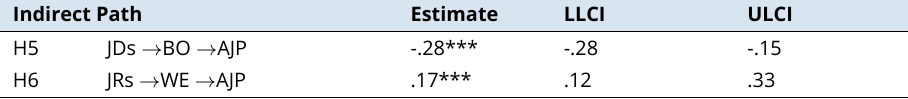
Mediation Analysis Indirect Path